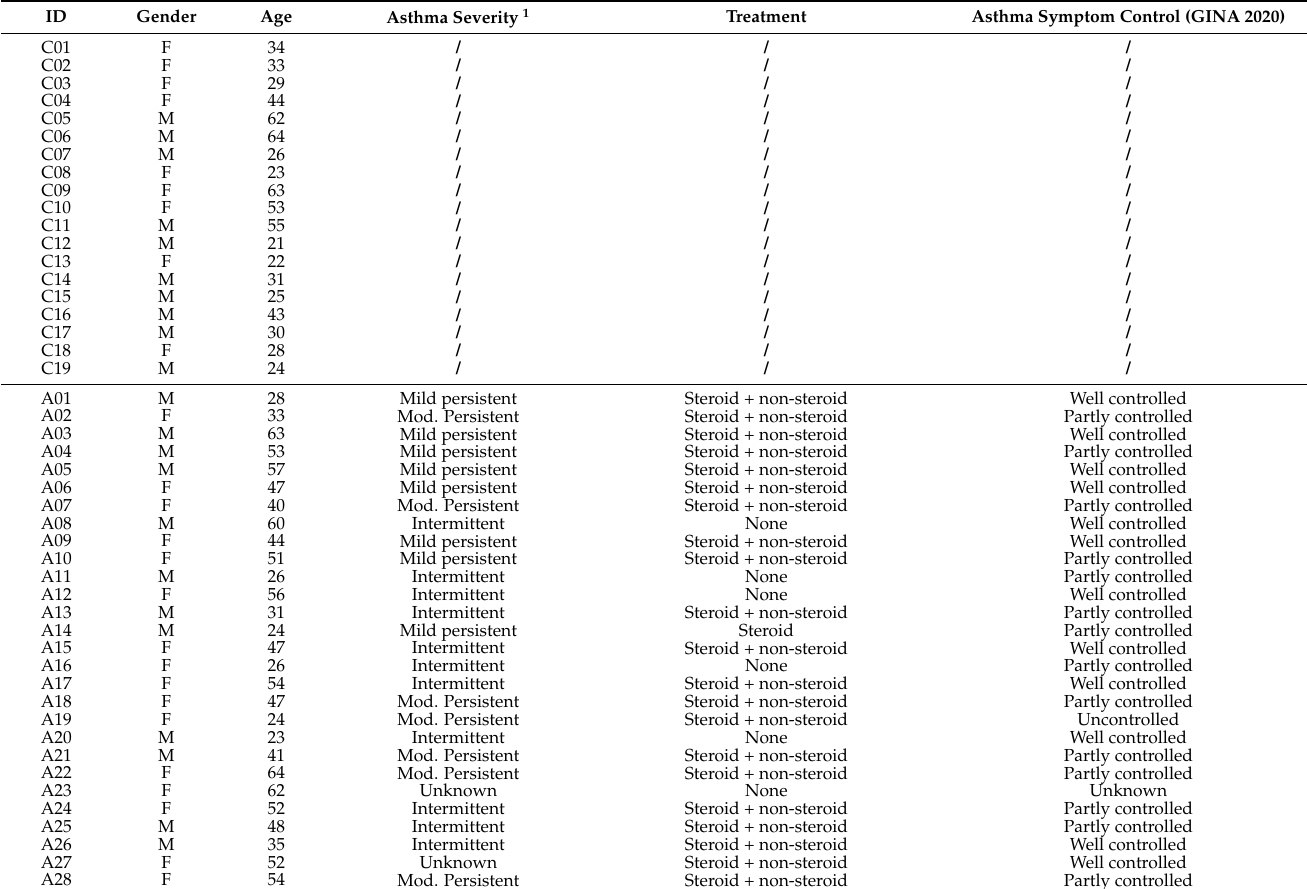
Table 1. Clinical characteristics of the control and asthmatic individuals in the human AZCRA